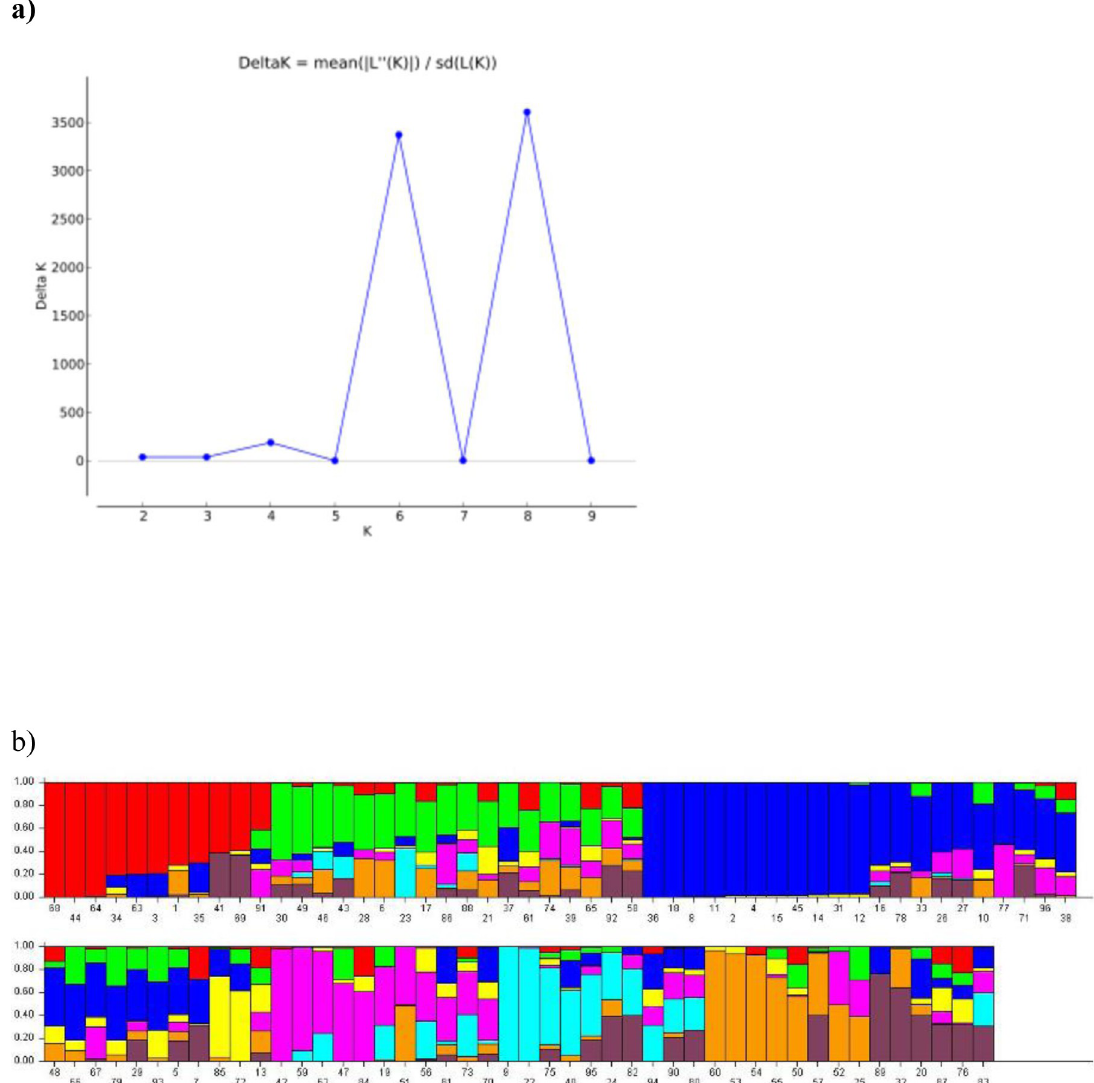
Fig 3. SNP marker based population structure. a) Delta K plot at different K-value based on the maximum likelihood method b) Barplot of K = 8 with genotypes in each sub-population depending on their inferred